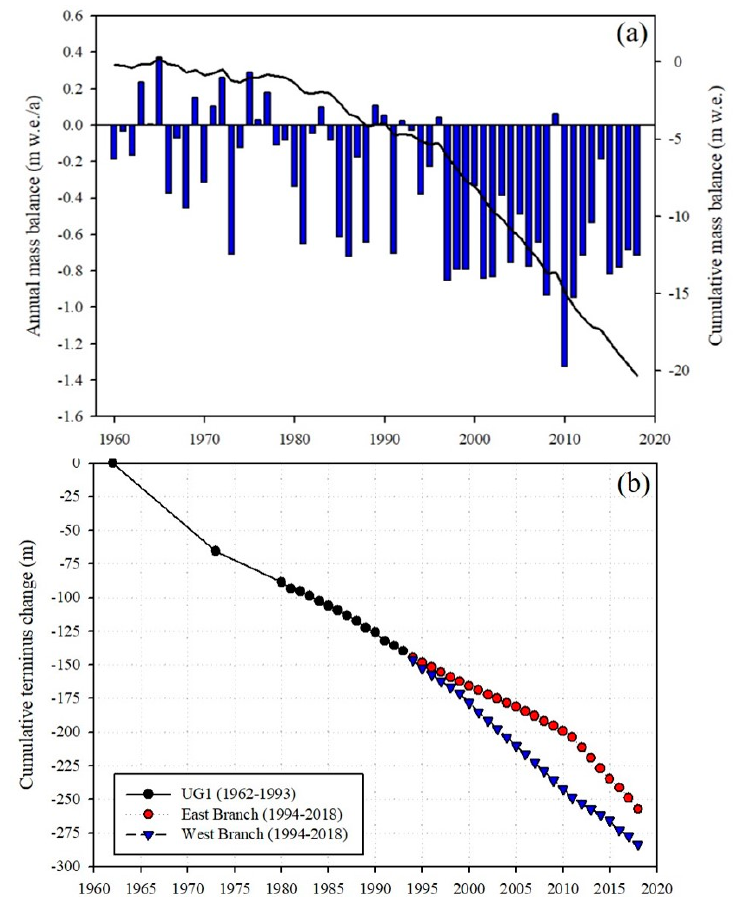
Figure 3. The example of the ( a ) annual and cumulative mass balance during 1960–2018 and ( b ) terminus changes during 1962–2018 for the UG1 in the Tien Shan.